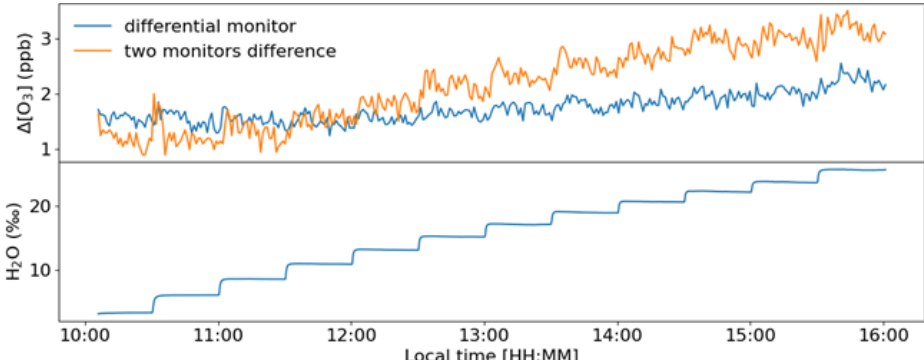
Figure 8. Experiment with increasing humidity in the air supplied to the TORM. The humidity content of the sample air is displayed in the lower graph in units of parts per thousand (‰). A total of 12 levels were administered from ≈ 3‰–26‰, which at room temperature conditions (25 ◦ C) is approximately equivalent to an RH range of 10%–84%.